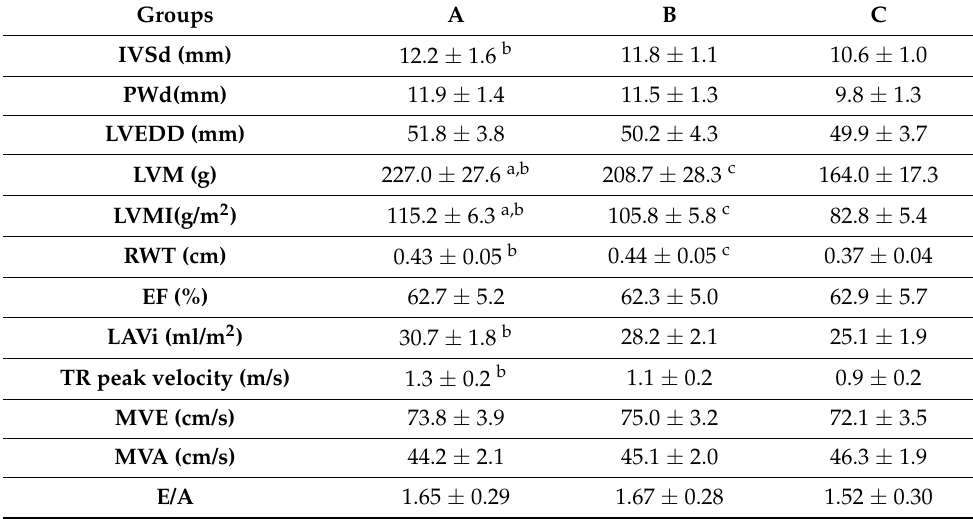
Table 4. Echocardiographic results (mean ±